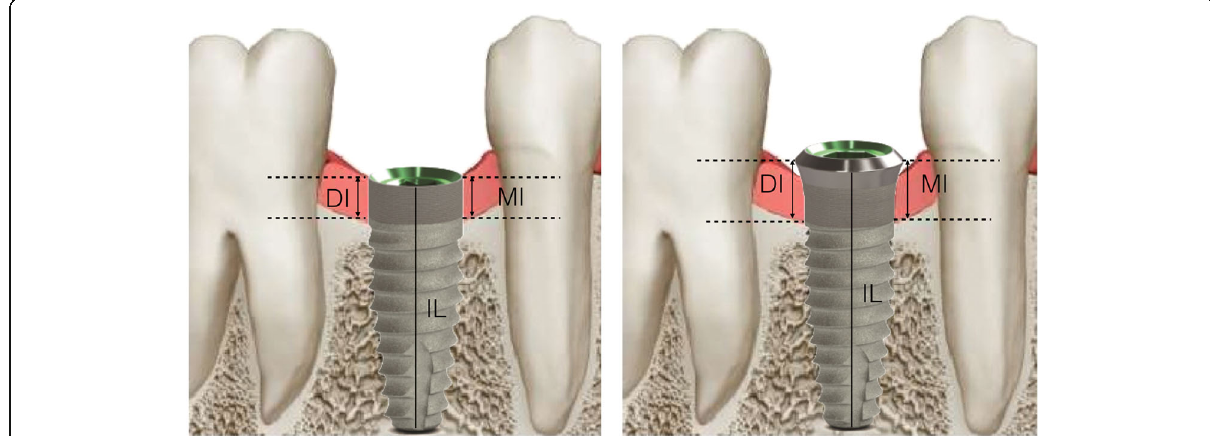
Fig. 4 Schematic view of radiographic measurement references